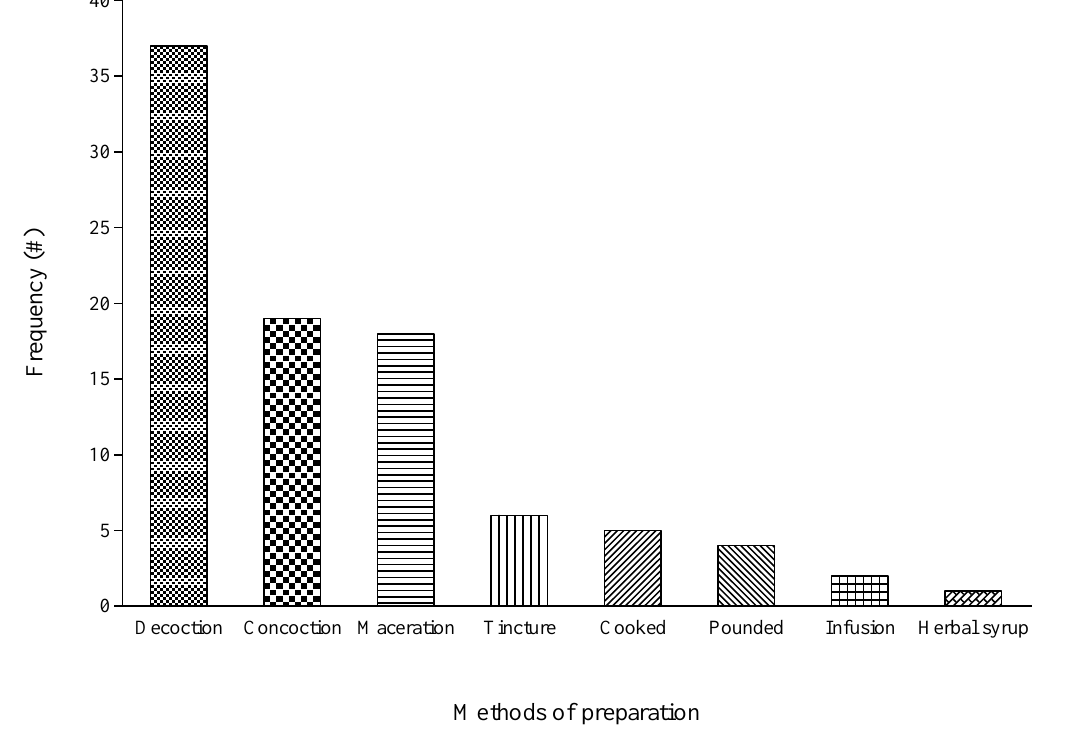
Figure 5. Methods of preparing plant species used for managing cough associated with respiratory diseases in Ede South Local Government Area of Osun State, Nigeria.